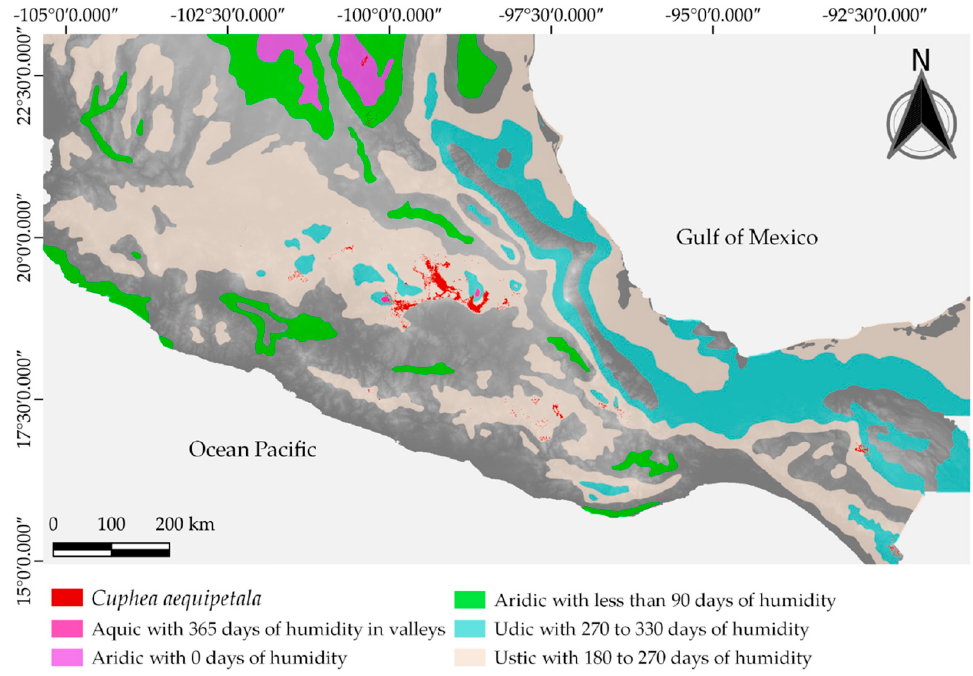
Figure 5. Contrast analysis created by overlapping the potential distribution of Cuphea aequipetala Cav. with a map of moisture regimes in Mexico.